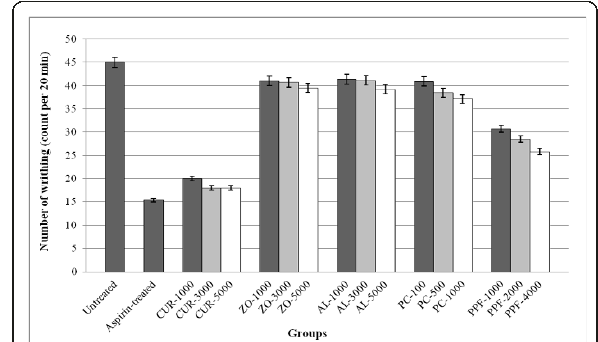
Figure 7 Peripheral analgesic activity (represented by mean ± SEM) number of writhing and stretching in writhing test) of CUR compound and extracts of ZO, AL, PC, and PPF at various dose levels, in comparison with untreated control and aspirin (reference control) . Statistically significant difference by ANOVA, followed by post hoc scheffe test: CUR-treated group at low dose level vs. control group (p < 0.01). CUR-treated group at medium dose level vs. control group (p < 0.001). CUR-treated group at high dose level vs. control group (p < 0.001). Aspirin-treated group vs. control group (p <